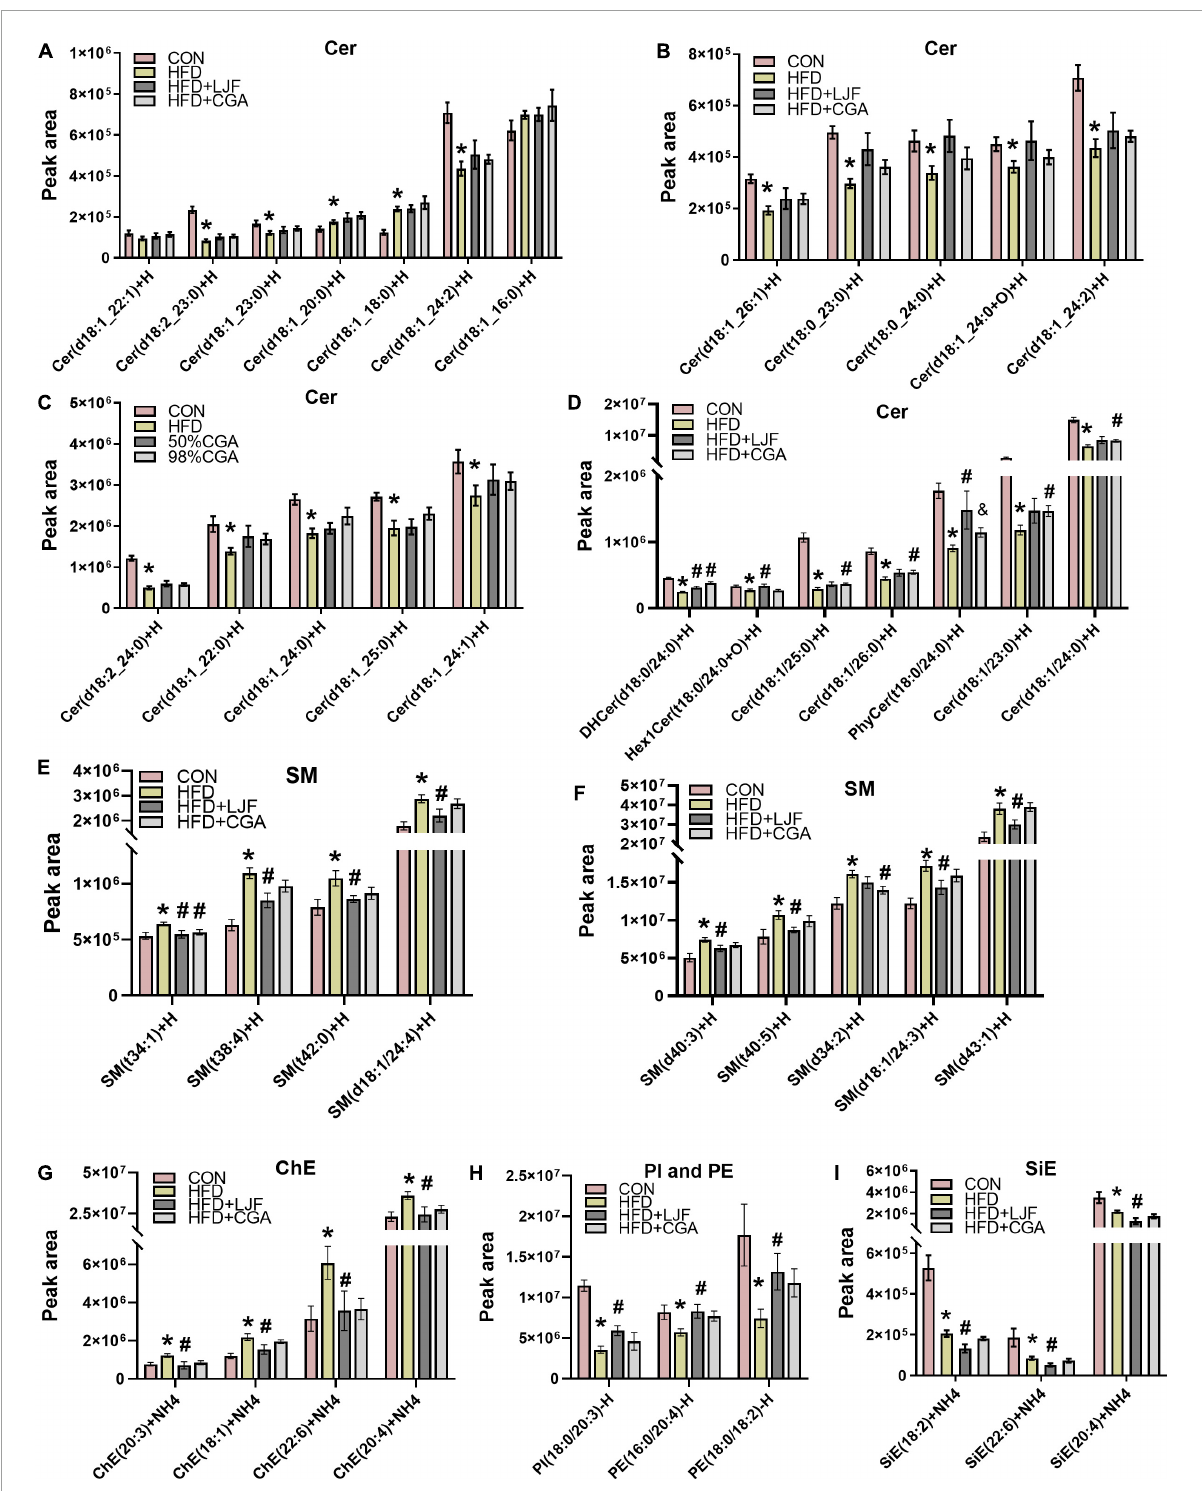
FIGURE5 Lonicerae Japonicae Flos and CGA regulated plasma sphingolipids levels. (A–D) Lipidomic Analysis in rat plasma concentrations of ceramide (Cer) species. (E–I) Plasma concentrations of sphingomyelin (SM), cholesteryl ester (ChE), sitosterol ester (SiE), phosphatidylethanolamine (PE), and phospha-tidylinositol (PI). Data are presented as bar graphs with means ± SEM ( n = 8 per group). * P < 0.05, vs. CON group; # P < 0.05, vs. HFD group; & P < 0.05, vs. HFD +